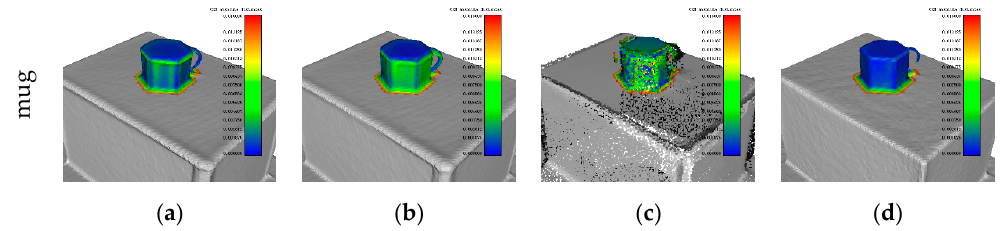
( a ) ( b ) ( c ) ( d ) Figure 11. Heat maps of cloud to mesh (C2M) distances for qualitative evaluation of the reconstructions. The compared algorithms are ( a ) KinectFusion [1]; ( b ) Zhou et al. [23]; ( c ) ElasticFusion [20]; and ( d ) our approach. Rows 1~3 are reconstructions of the synthetic data, rows 4~9 are the real-world reconstructions (only the 3D printed objectives are evaluated, with other areas of the scenes grayed out). The scale of the color bar is 0 ∼ 15mm among all the tests.